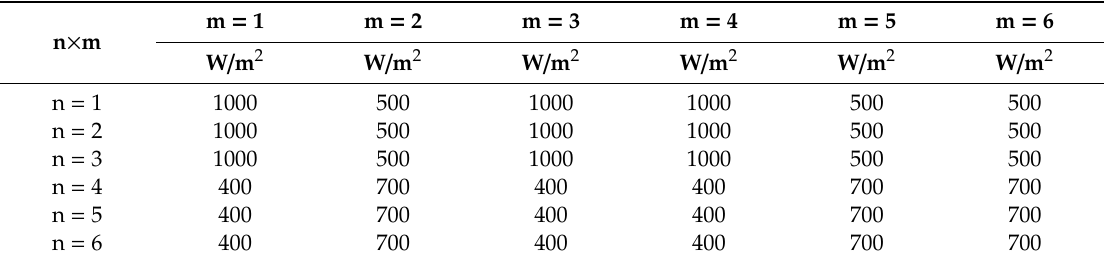
Table 4. Non-uniform shading pattern of PV array for F3 and F4.